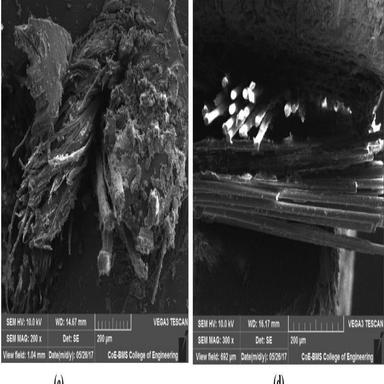
(a)–(e) SEM images of the fractured specimens.